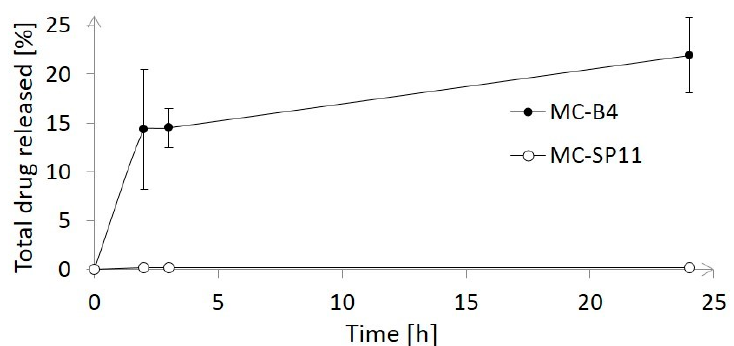
Figure 6. Drug release profiles for the MC-B4 and MC-SP11 nanocarriers at 37 °C.